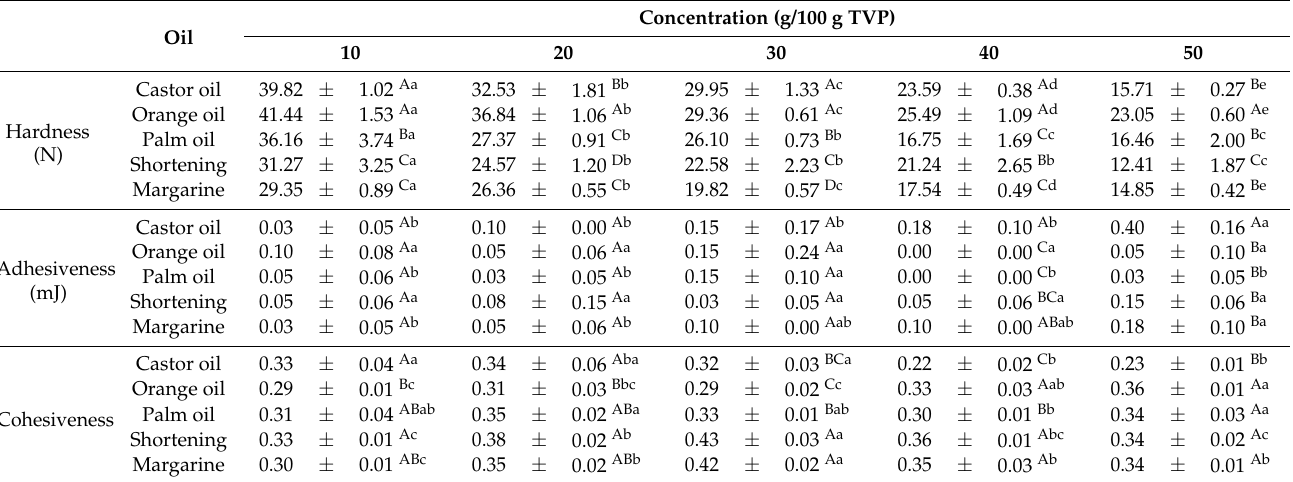
Table 7. Texture profile analysis (hardness, adhesiveness, and cohesiveness) of meat analog supple- mented with different types or amounts of vegetable